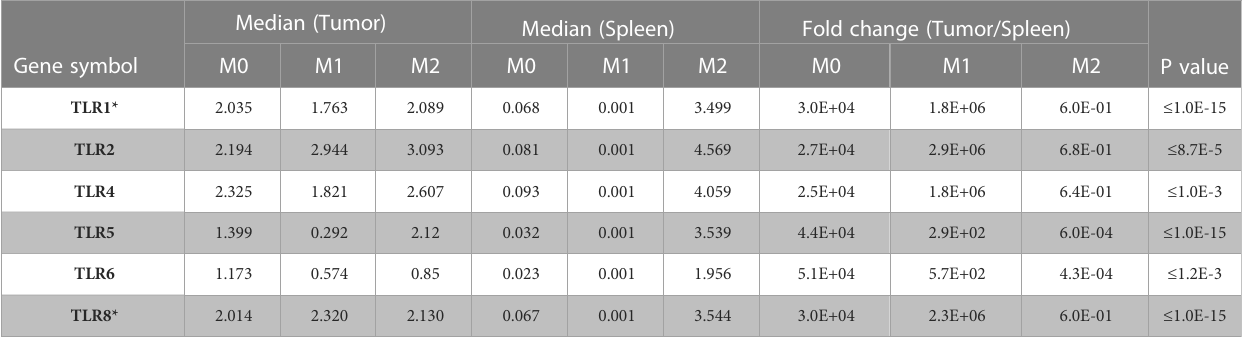
TABLE 3 Differentially expressed TLRs in the three macrophage subtypes in DLBCL. Median Gene symbol